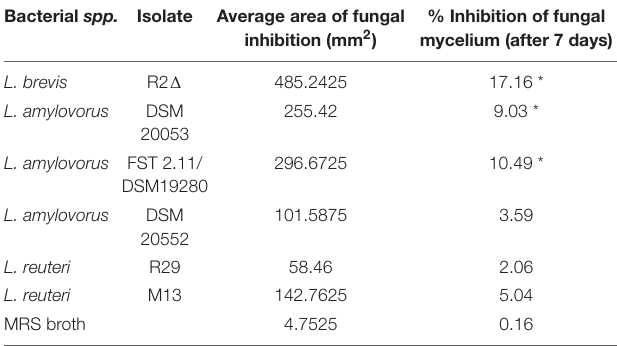
TABLE 3 | Percentage of growth inhibition of F. graminearum by six Lactobacillus species under in vitro dual-culture conditions. Bacterial spp. Isolate Average area of fungal % Inhibition of fungal inhibition (mm 2 ) mycelium (after 7